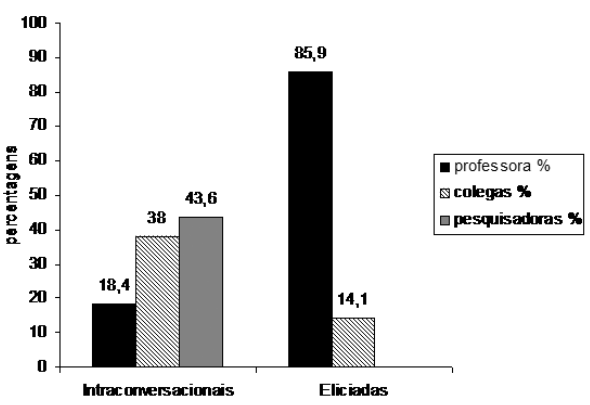
Figura 3. Percentagem da participação de cada tipo de interlocutor nas narrativas intraconversacionais (NIs) e nas eliciadas